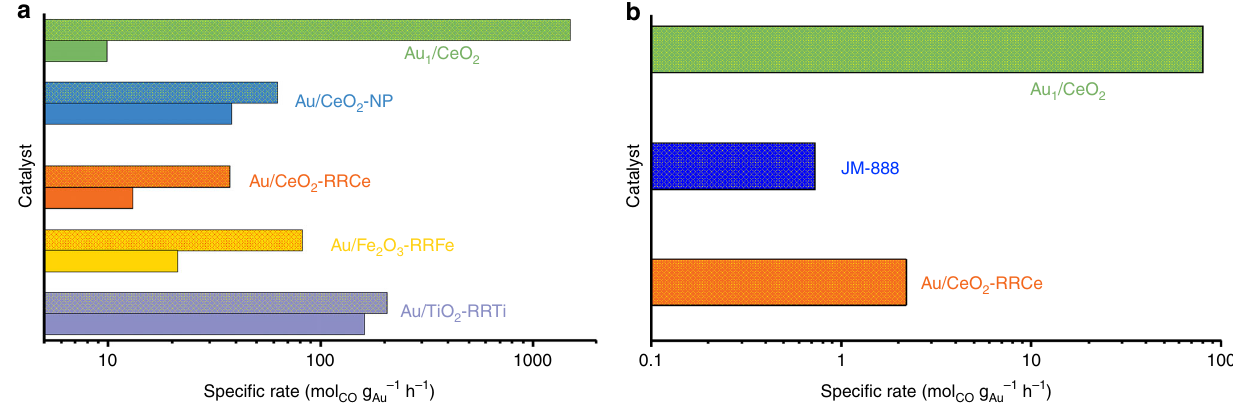
Fig. 2 Comparison of CO oxidation activities on different catalysts. a Speci fi c rate of CO oxidation at 200 °C with (patterned bar) or without (solid bar) the presence of H 2 O on Au 1 /CeO 2 , Au/CeO 2 -NP and various standard Au catalysts provided by Haruta Gold Inc. Reaction gas: 1 vol% CO + 1 vol% O 2 ( + 2 vol % H 2 O) balanced with He; b Speci fi c rate of CO oxidation under simulated practical conditions on Au 1 /CeO 2 , Au/CeO 2 -RRCe and commercial